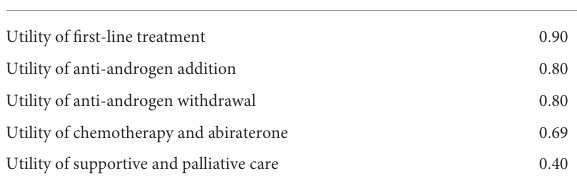
TABLE 7 Utility values for each disease state.